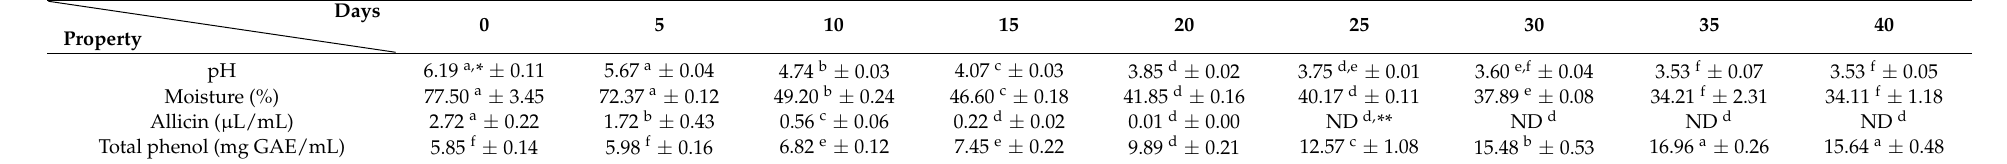
Table 1. Biochemical properties of fresh garlic and black garlic (BG) aged for different durations.